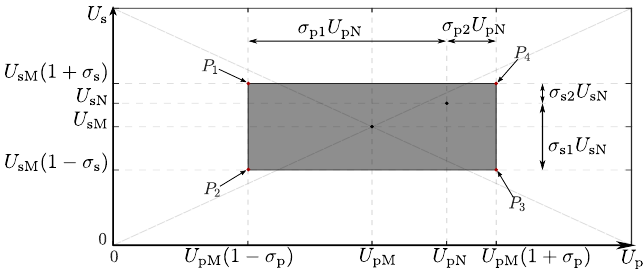
Figure 5. The operation region of the converter with the nominal point shown by ( U pN , U sN